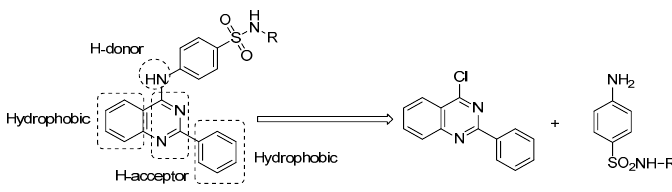
Figure 2. The designed quinazoline-sulfonamide hybrids.